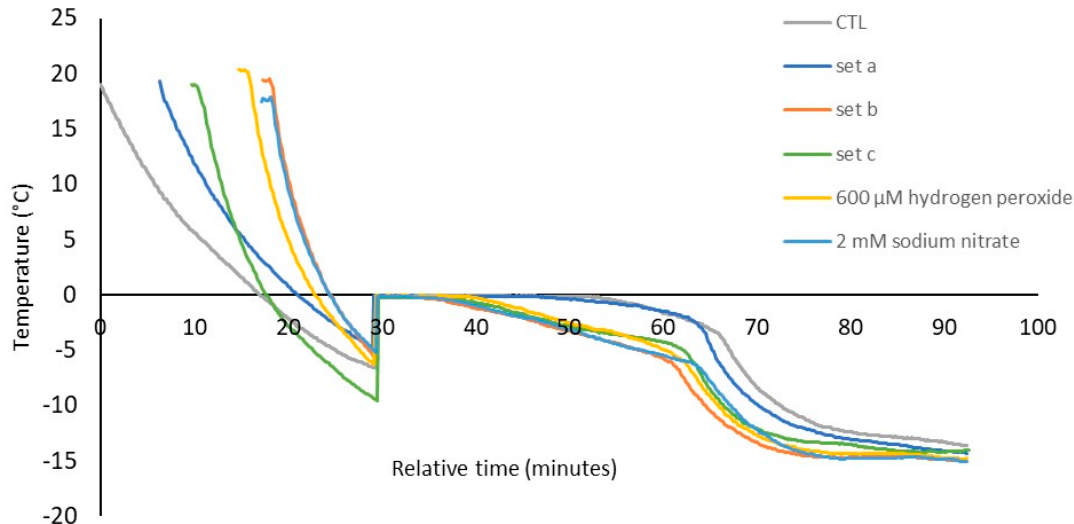
Figure 11. Freezing curve of PAW.